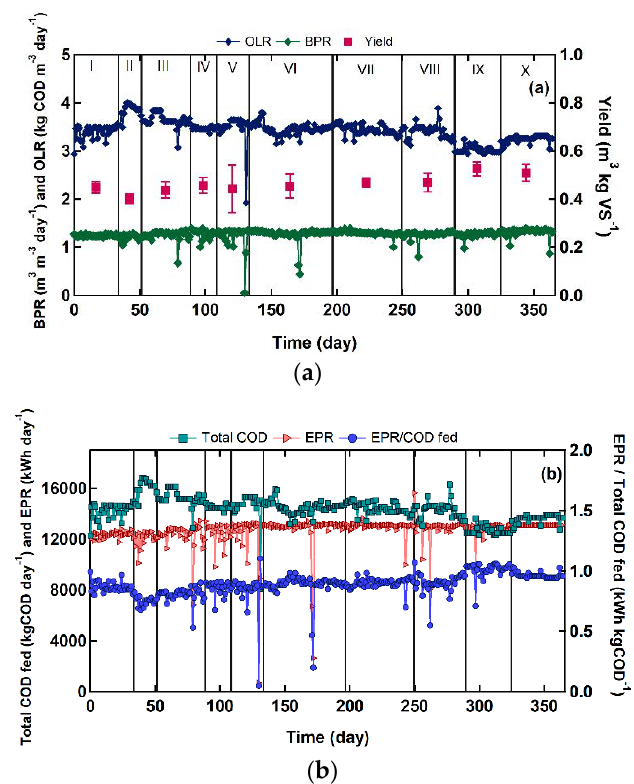
Figure 4. ( a ) Organic loading rate (OLR), the biogas production rate (BPR) and the resulting yield, and ( b ) the total chemical oxygen demand (COD) loading, the electrical energy production rate (EPR) and the yield of the electrical energy per COD fed, versus time during one-year of operation.